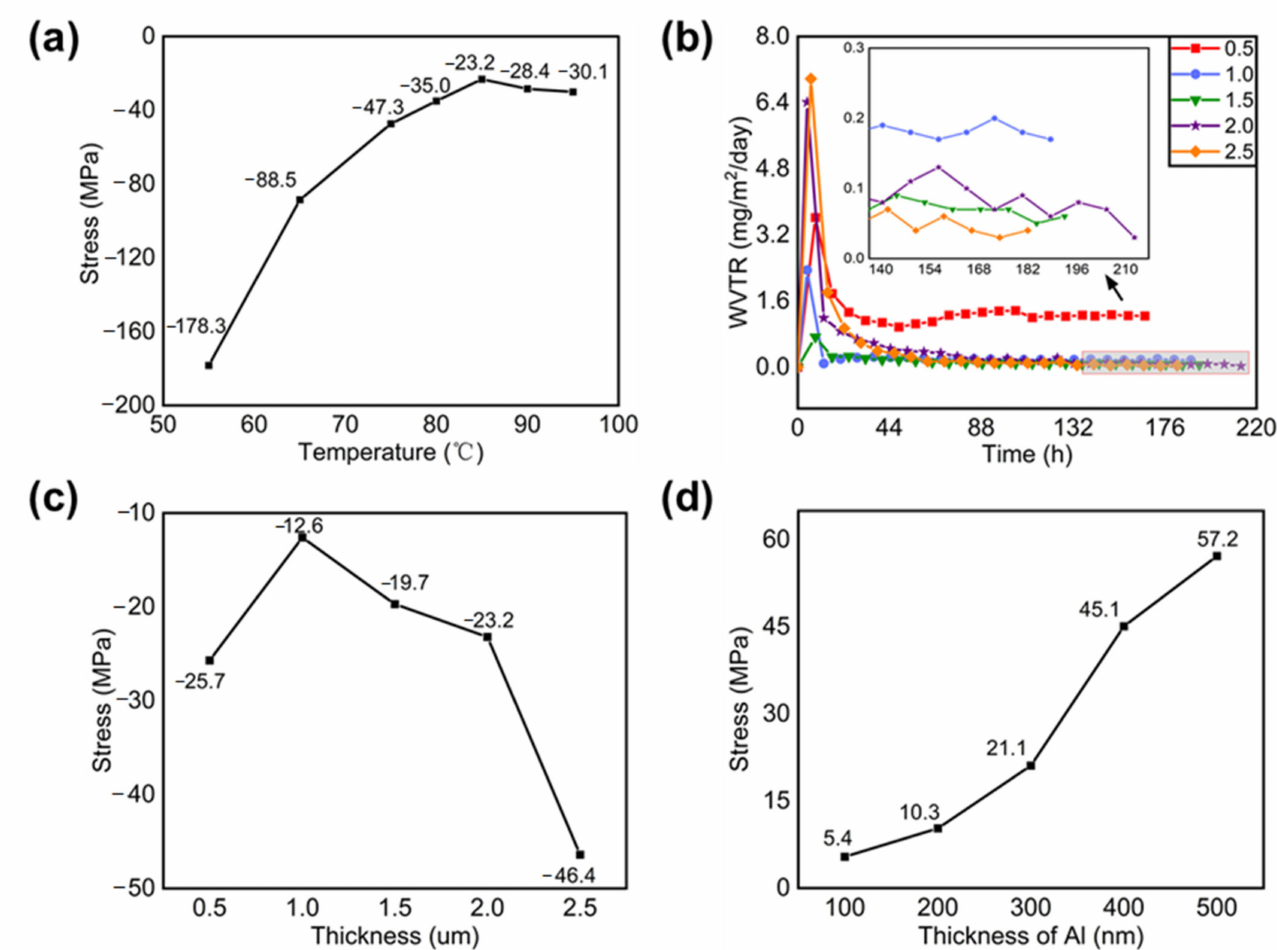
Figure 1. ( a ) Residual stress of 2- µ m-thick Si x N y at different deposition temperatures, ( b ) WVTR and ( c ) residual stress of the Si x N y prepared at 85 ◦ C with different deposition thicknesses, and ( d ) residual stress of Al with different deposition thicknesses.